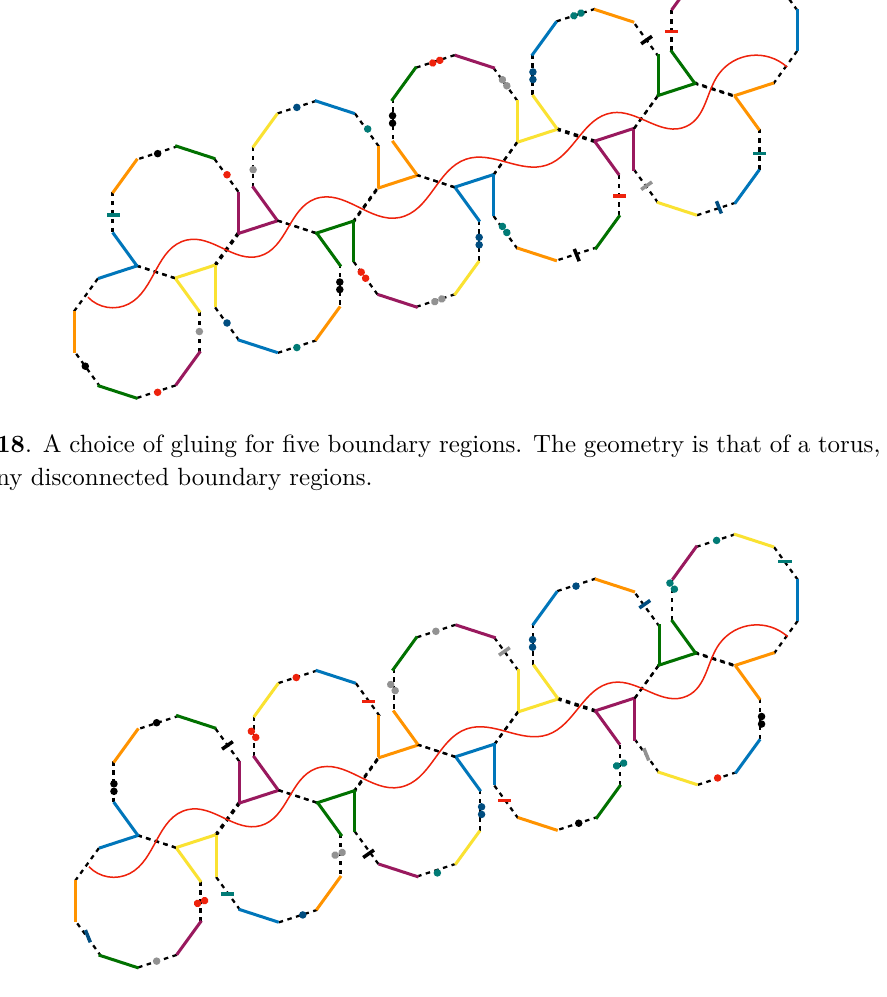
Figure 19 . A choice of gluing for five boundary regions. The topology is no longer that of a